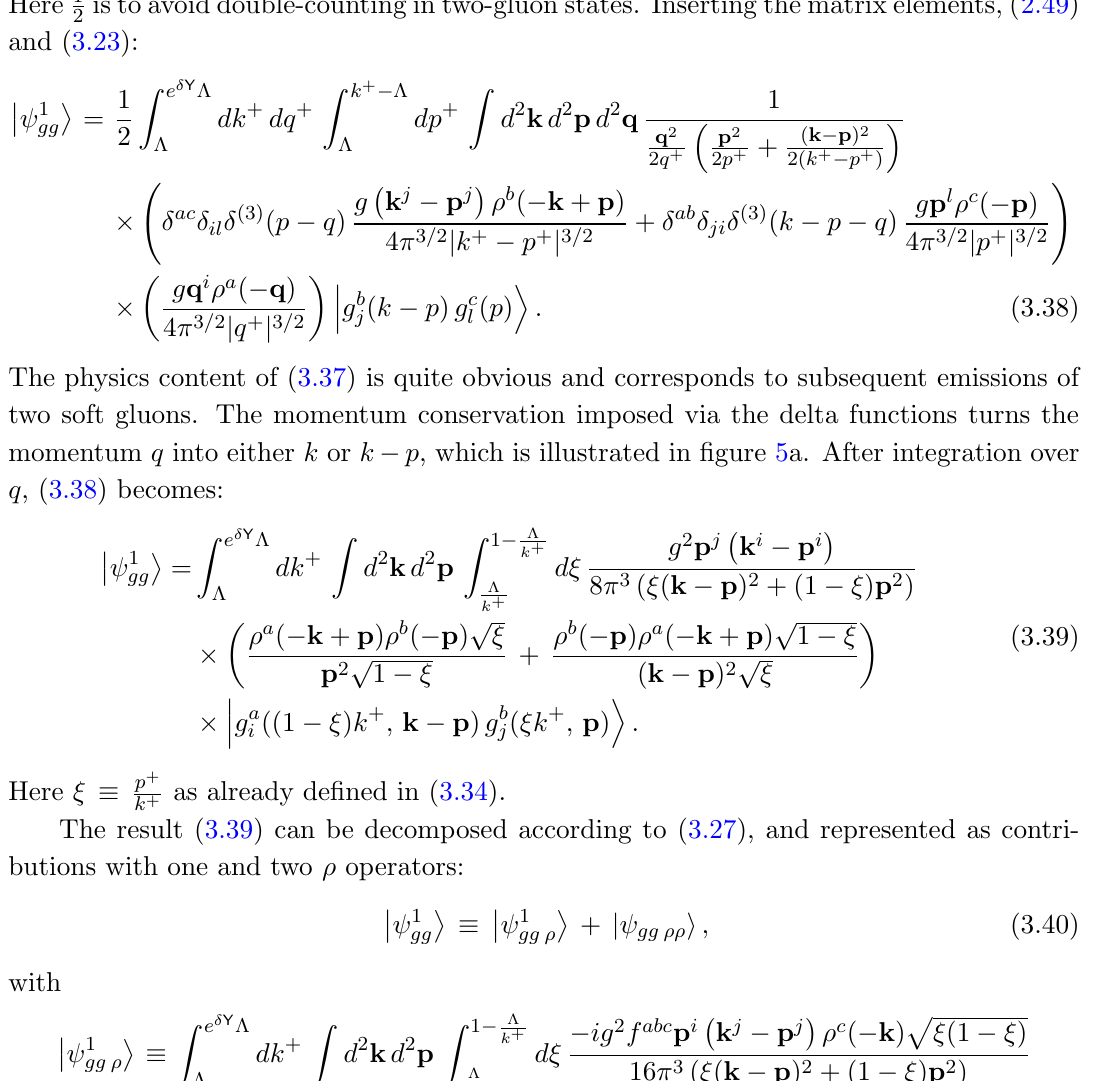
(cid:12) (cid:11) , (b) - (cid:12) 1 gg